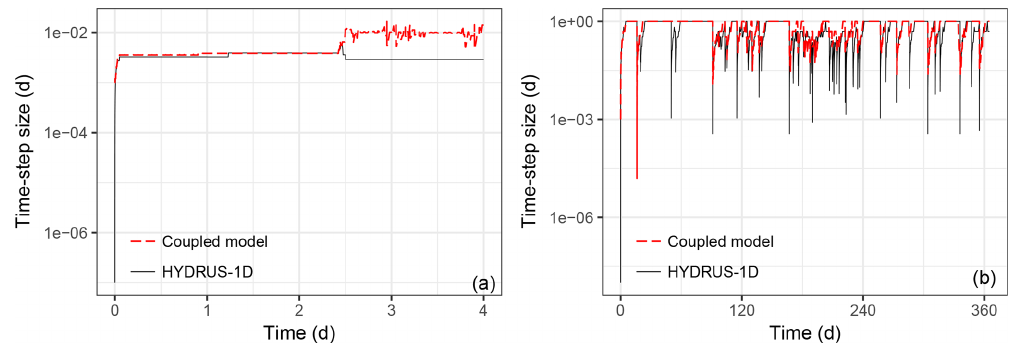
Figure 7. The time-step sizes through the simulation of (a) sudden infiltration into a dry sandy soil column and (b) rapidly changing atmospheric upper boundary conditions with a layered soil column.